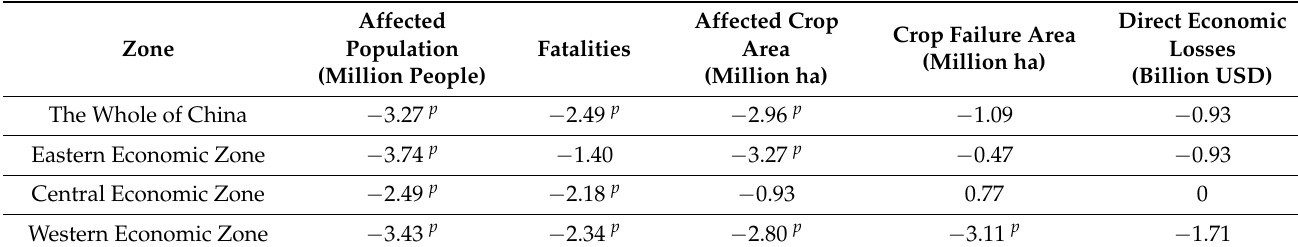
Table 2. Trends in various losses caused by natural disasters in China during 2010–2020.